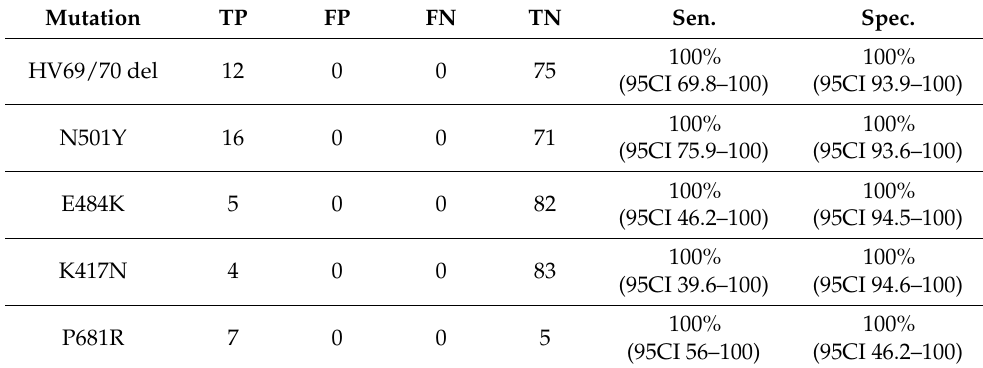
Table 1. Sensitivity and specificity